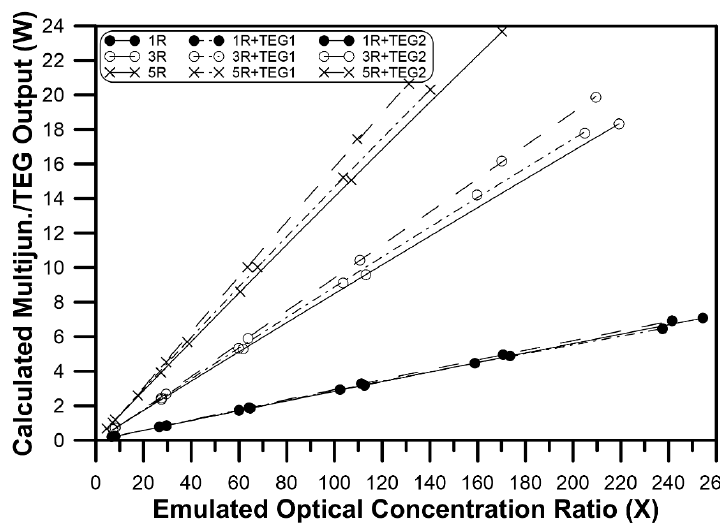
Figure 10. Total output of the Ga 0.35 In 0.65 P/Ga 0.83 In 0.17 As multijunction PV cell coupled to TEGs.